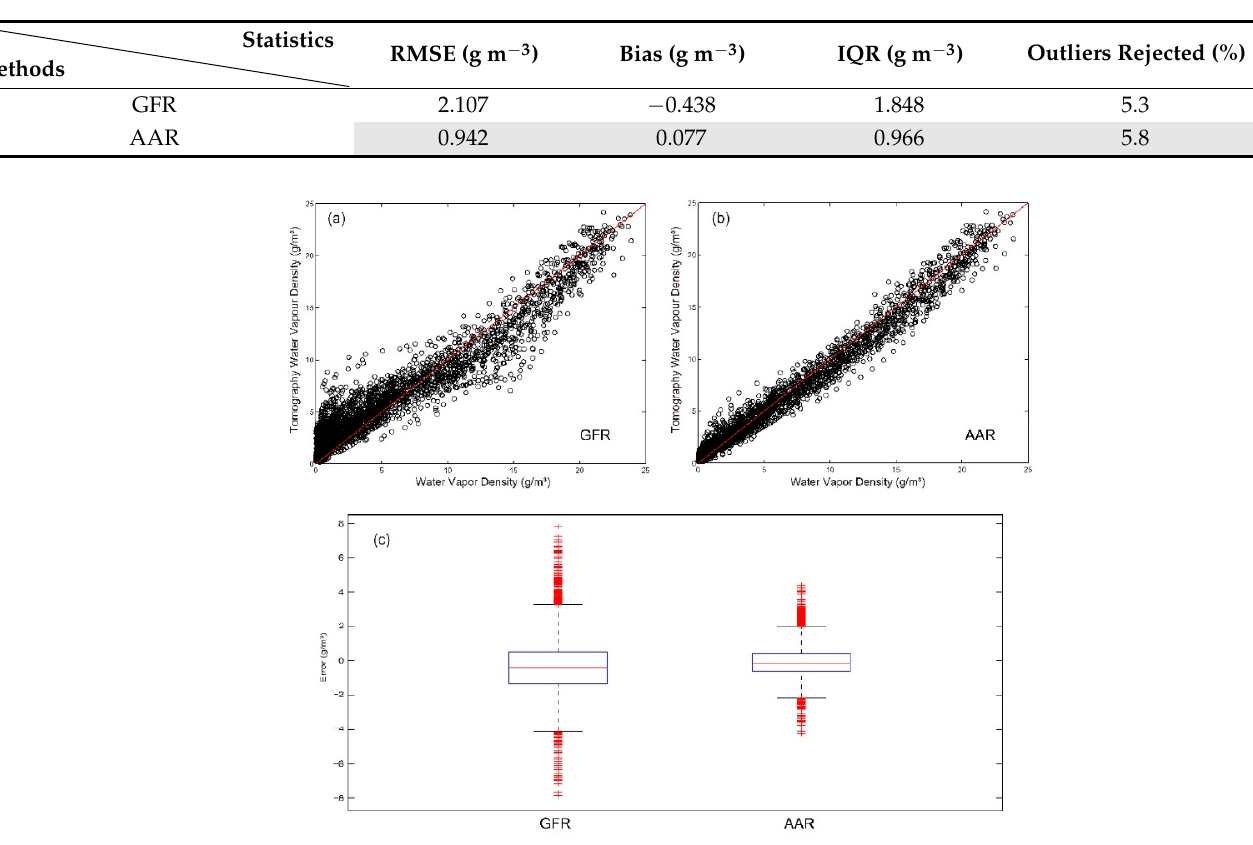
Figure 7. Graphs showed the statistical results of water vapor tomography for GFR and AAR in September 2020: ( a ) and ( b ) are the comparison of radiosonde data with two schemes (GFR and AAR) by the scatter plots, and ( c ) is the comparison of error in tomographic results by box plots.